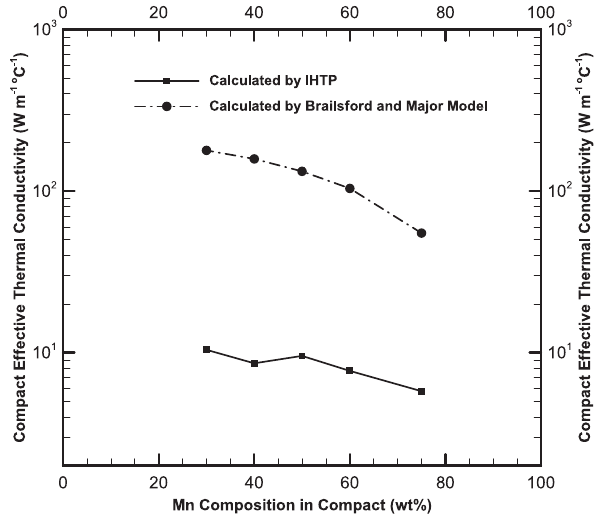
Fig. 18: Comparison between compact effective